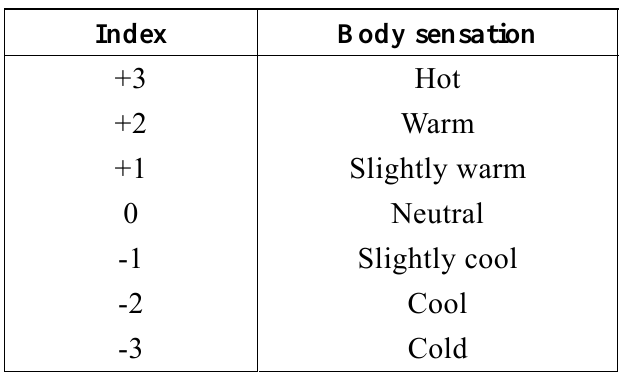
Table 2. PMV indicators and body